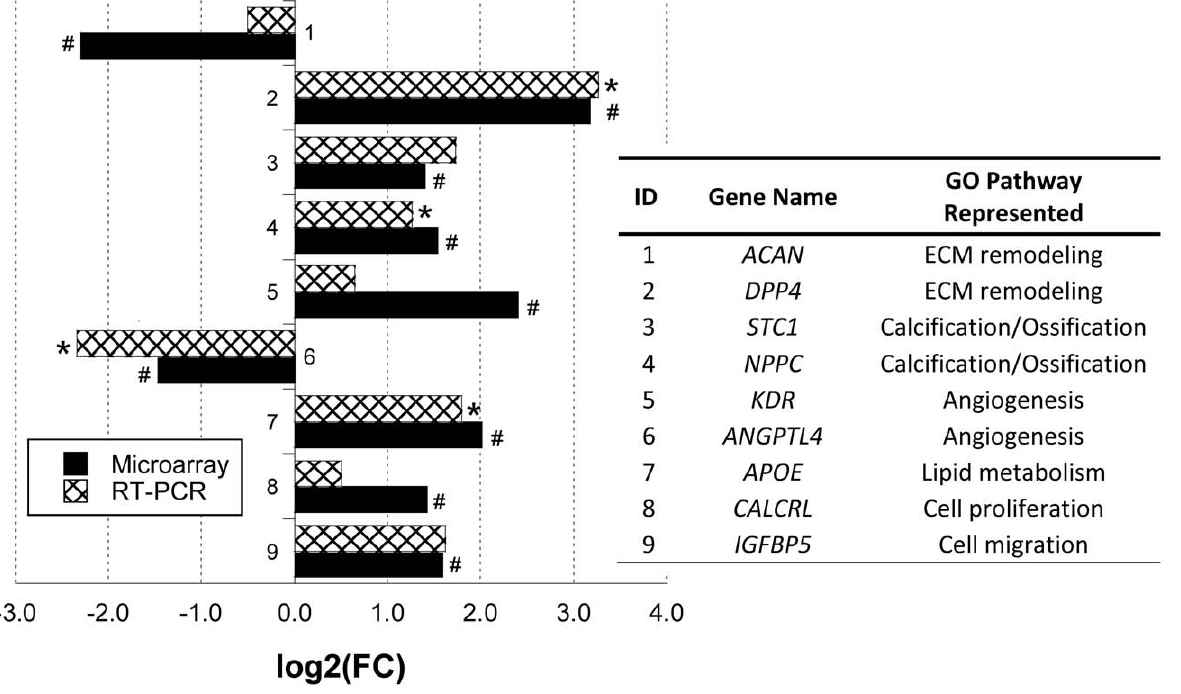
Figure 1. qRT-PCR validation of microarray data. Data are displayed as mean log2(fold-change) in gene expression in male versus female samples. Gene abbreviations: aggrecan ( ACAN ), dipeptidyl-peptidase 4 ( DPP4 ), stanniocalcin 1 precursor ( STC1 ), natriuretic peptide precursor C ( NPPC ), kinase insert domain receptor ( KDR ), angiopoietin-like 4 ( ANGPTL4 ), apolipoprotein E ( APOE ), calcitonin receptor-like ( CALCRL ), and insulin-like growth factor binding protein 5 ( IGFBP5 ). *P , 0.05 compared to female VIC RT-PCR results, # P , 0.05 compared to female VIC microarray results.